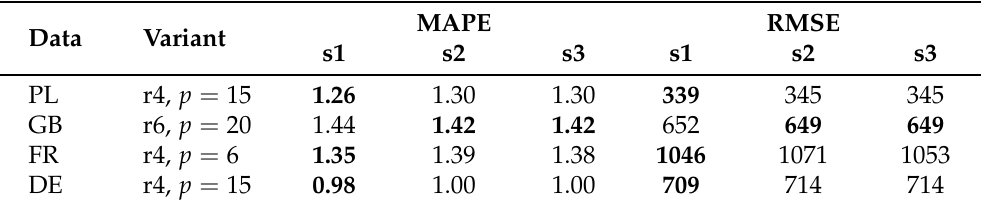
Table 3. Validation MAPE and RMSE for different methods of split predictor selection (training mode: global extended, #trees: 300, minimum leaf size: 1; lowest errors in